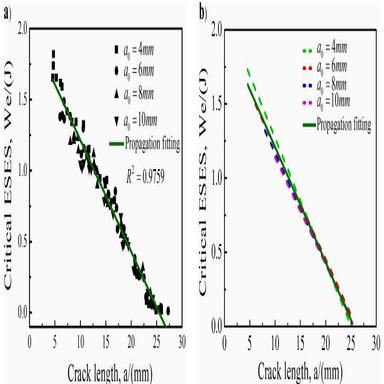
(a) The overall fitting line between the elastic strain energy storage We and various crack lengths a of the U-notches with different initial lengths during the crack propagation. (b) The comparison among five fitting lines of the U-notches with different initial lengths during the crack propagation.